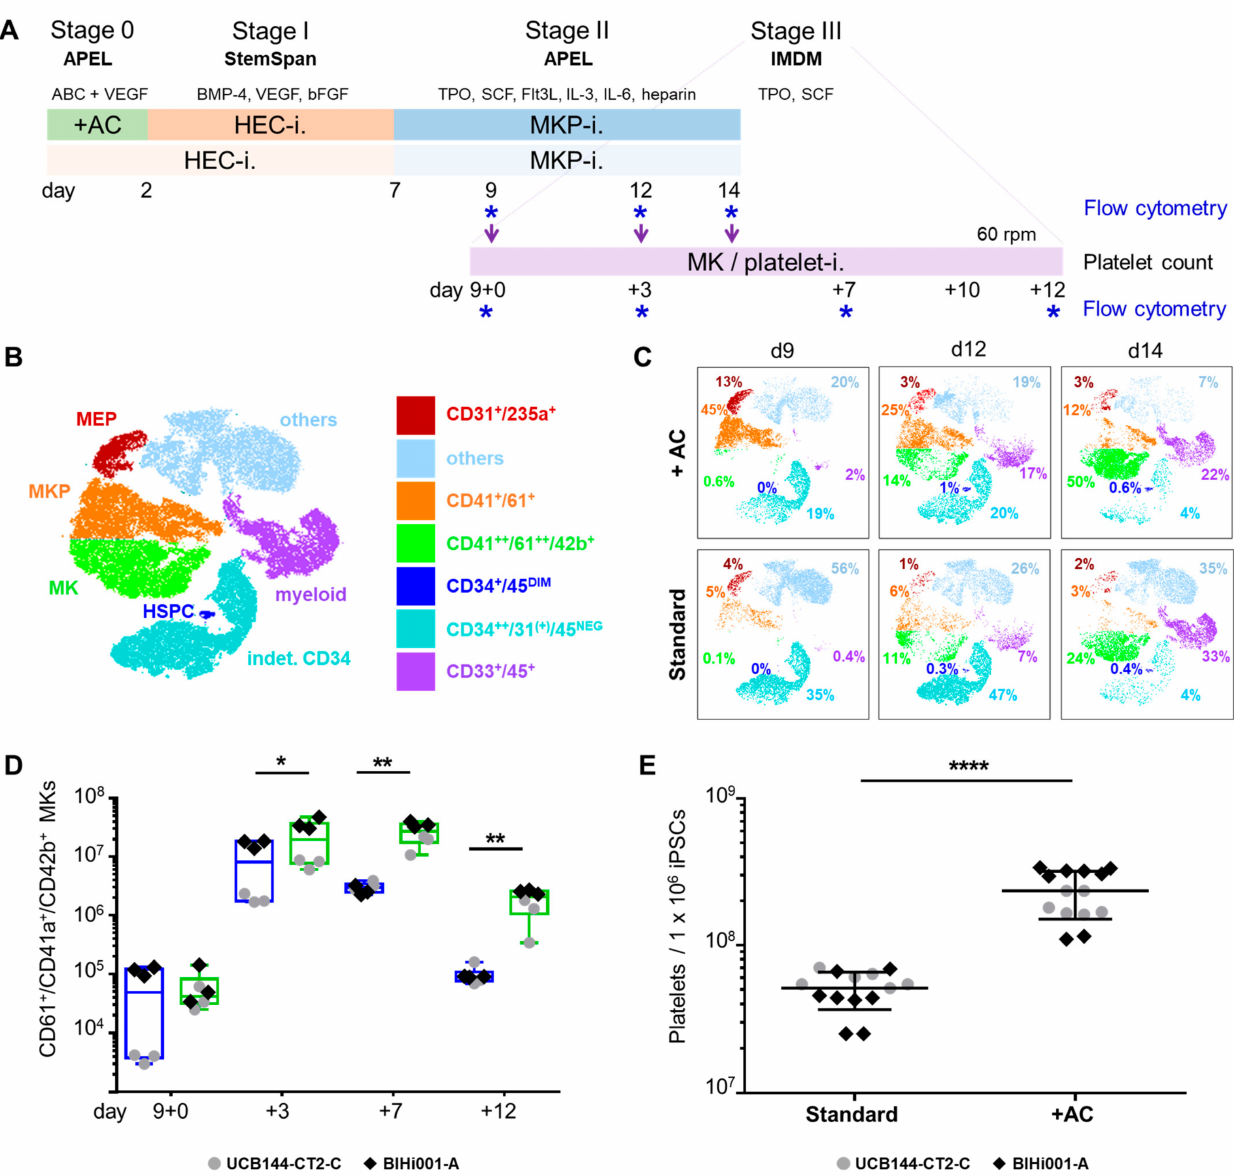
Figure 4. Validation of improved platelet production from hiPSCs. ( A ) Platelet production from hiPSCs comparing the improved protocol (stage 0, +AC) followed by hemogenic endothelial cell induction (HEC-i., stage I) and megakaryocyte progenitor induction (MKP-i., stage II) to a standard protocol, both finished with platelet production in IMDM supplemented with TPO and SCF (stage III). From day 9 + 10 on, MKs were cultured under dynamic conditions on an orbital shaker at 60 rpm. Cells were analyzed by flow cytometry. ( B ) Color code legend for t-distributed stochastic neighbor embedding (tSNE) plots defining MKs, MKPs, megakaryocyte erythroid precursors (MEP), myeloid cells (myeloid), indetermined CD34 + /45 NEG cells (indet. CD34; reduced CD31 expression compared to early HECs) and other cells not allocated to main hematopoietic populations within the 10-color flow cytometry panel (others). Phenotypic identifiers as depicted in the legend insert. ( C ) Individual tSNE plots for stage II MKP culture constituents measured on days 9, 12, and 14 in cultures with (+ AC) and without initial induction, respectively. Results are depicted using the same tSNE color code. ( D ) The total amount of CD61 + /CD41a + /CD42b + MKs was significantly increased on day 9 + 3 ( p = 0.0191), day 9 + 7 ( p = 0.0037) and day 9 + 12 ( p = 0.0052; paired t-tests) using the improved protocol (green boxes) compared to standard conditions (blue boxes). Results from two independent hiPSC clones ( n = 6). ( E ) Platelet counts per input hiPSC on day 9 + 12 were significantly increased using the improved protocol ( p < 0.0001, unpaired t -test). Symbols depict two independent hiPSC clones (UCB144-CT2-C, grey circles and BIHi001-A, black diamonds, n = 7; measured in duplicates in D and E, * p < 0.05, ** p < 0.01 and **** p <